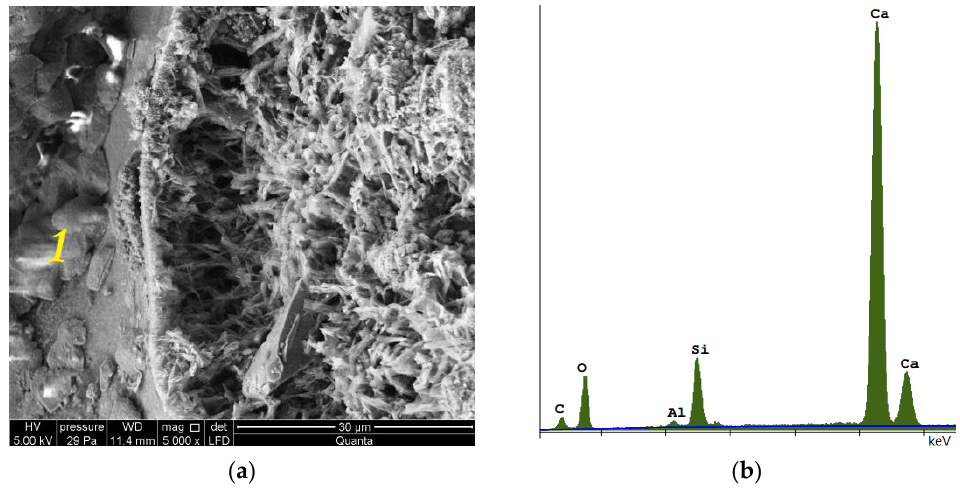
Figure 14. Photograph of the microstructure of traditional silicate brick (sand-lime) taken using SEM. ( a ) Picture of the microstructure of sand-lime sand brick. The image shows tobermorite in the form of thin plaques. ( b ) EDS spectrum of sand-lime sand brick in point 1.